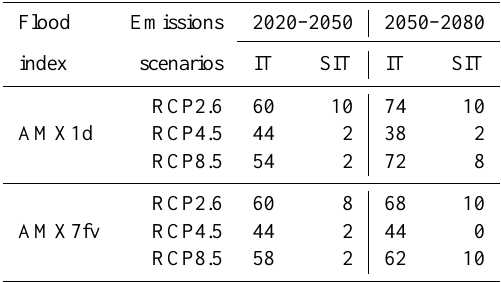
Table 1. Percentage of samples with increasing trends of AMX1d and AMX7fv in future periods based on five